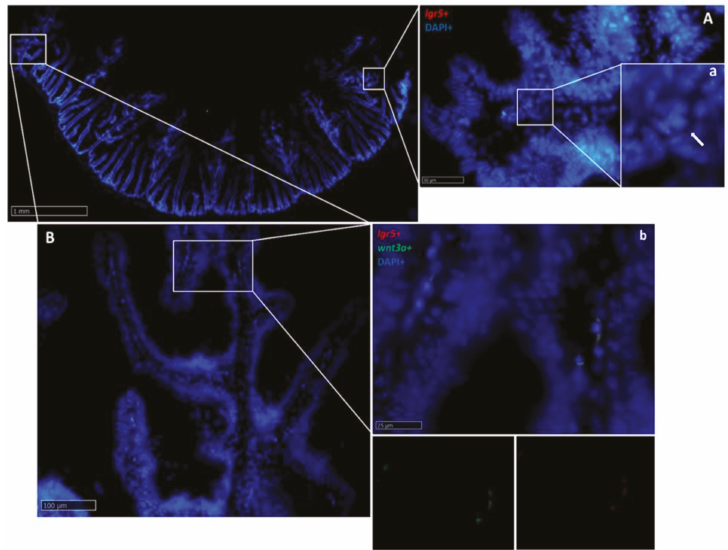
Figure 18. In situ hybridization of lgr5 and wnt3a mRNA in the second segment of the rainbow trout mid-intestine. Lgr5 (red dots) expression was low at the complex fold apex ( A , a ): higher magnification, arrow), but became higher at the base of the complex fold and in the rest of the second segment of the mid -intestine ( B , b ): higher magnification), where it colocalized with wnt3a along the villus connective axis ( b ).